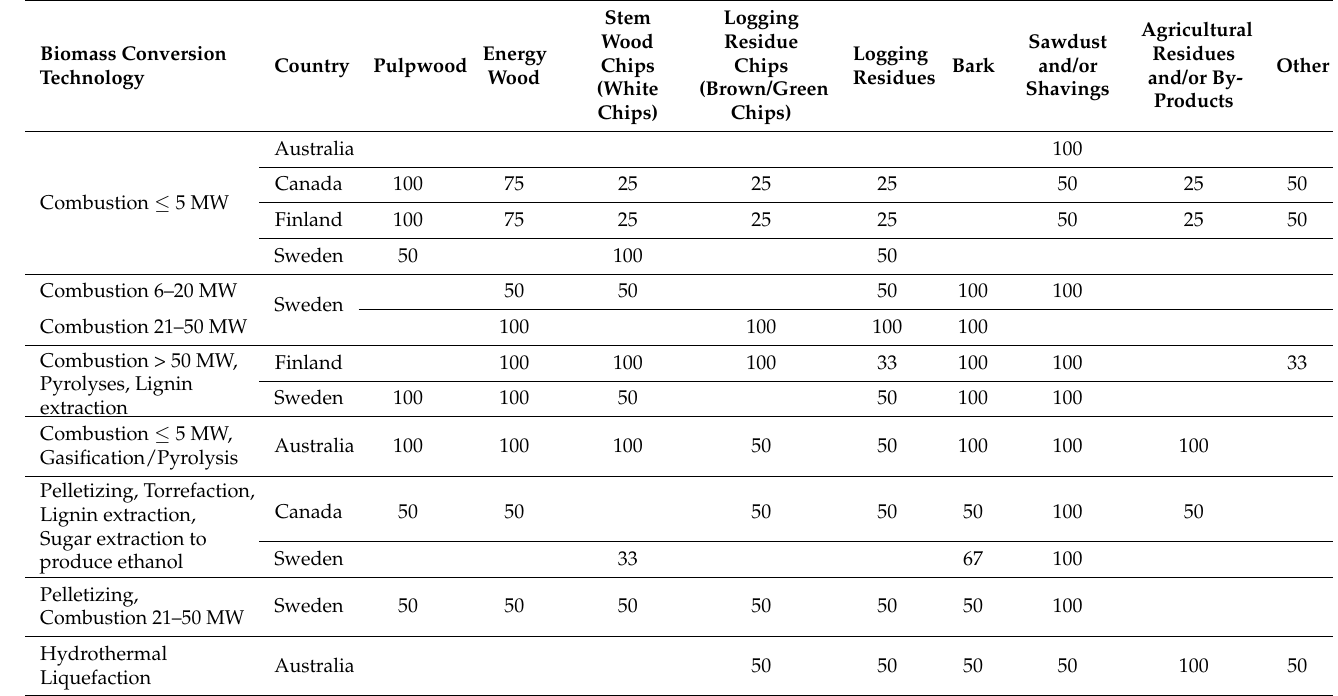
Table 3. Averaged percentage of biomass characteristics ( n = 27), grouped by conversion technology and